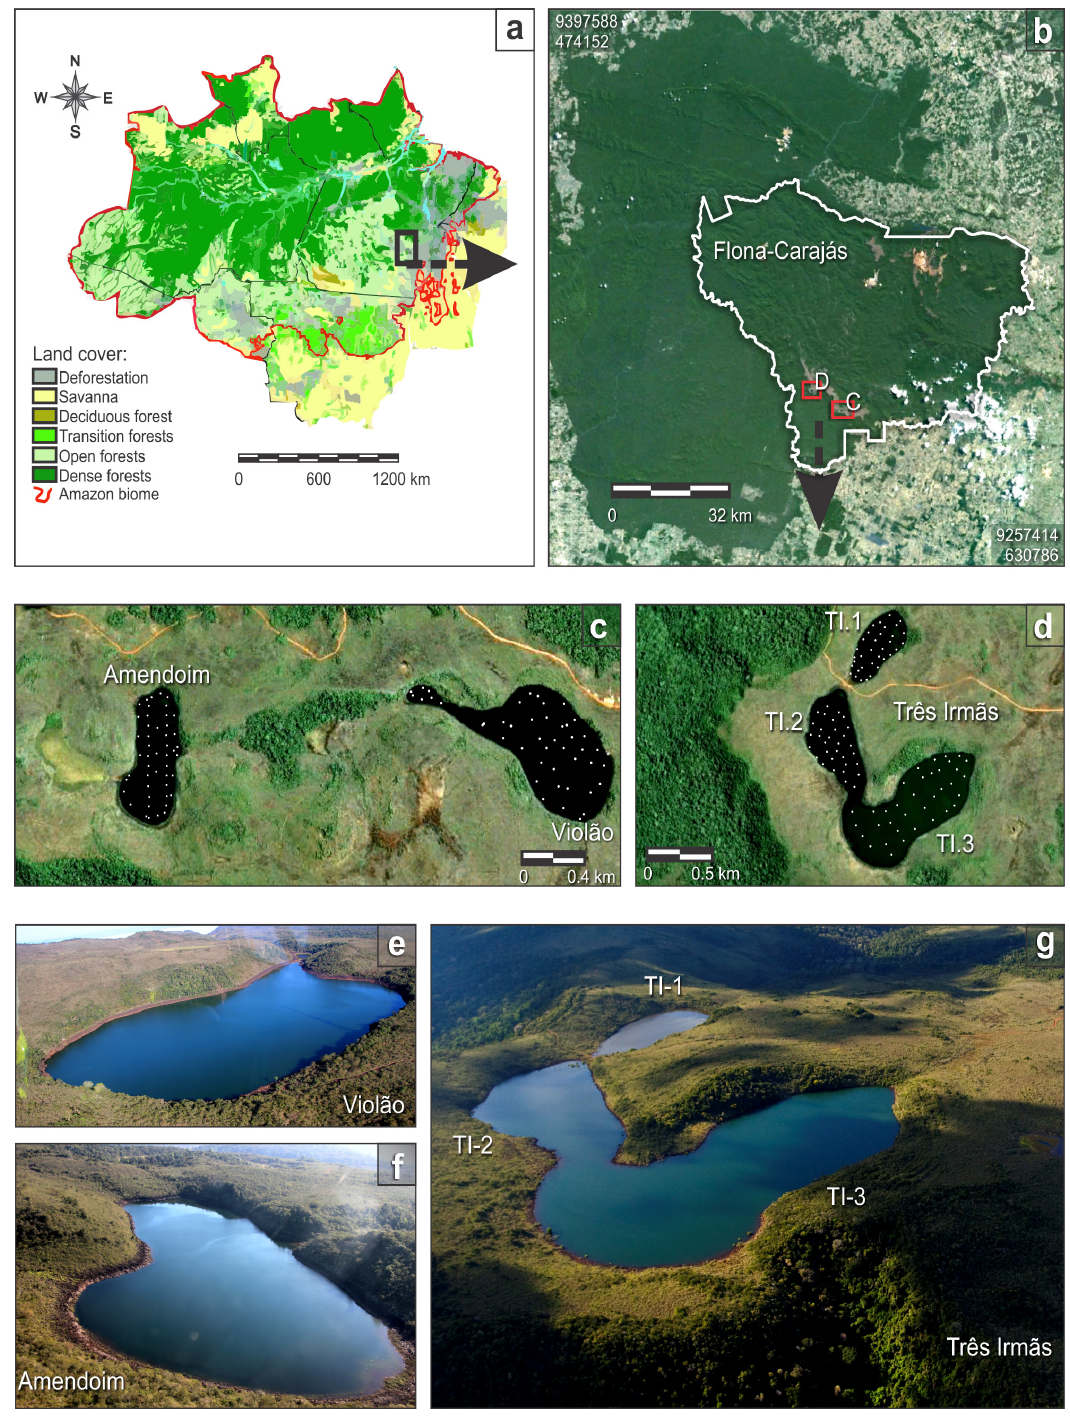
Figure 1 - a) Location map of the study site in the southeastern Amazon region (Imazon 2003) with a detail to b) Carajás National Forest (Flona-Carajás, Landsat image) and a detail to Serra Sul de Carajás and studied lakes; c) WorldView images of the Violão and Amendoim and d) Três Irmãs lakes in the eastern and western portion of the Serra Sul; sediment samples are represented by white dots; e) Aerial photography of the Violão, f) Amendoim and g) Três Irmãs